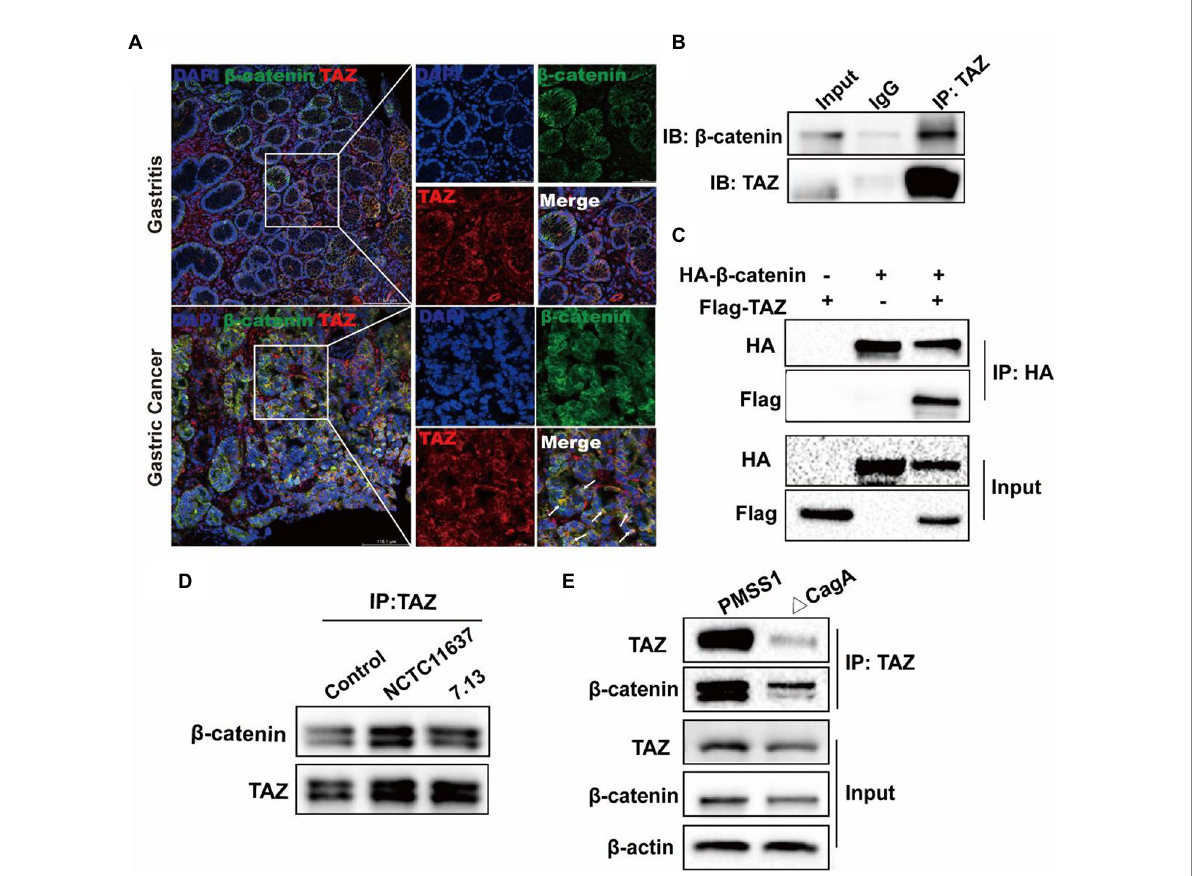
FIGURE 6 CagA+ H. pylori infection enhances the interaction of TAZ with β -catenin. (A) Immunofluorescence staining for TAZ and β -catenin colocalization in human gastritis and gastric cancer tissues (Magnification 200×, scale bars =116.1 μ m; and digital zoom, scale bars = 38.7 μ m). (B) Interaction between endogenous TAZ and β -catenin. Immunoprecipitation was performed with an anti-TAZ antibody followed by immunoblotting with the indicated antibodies. (C) Interaction between HA- β -catenin and Flag-TAZ. Immunoprecipitation was performed with an anti-HA antibody, followed by immunoblotting with the indicated antibodies. (D) AGS cells were cocultured with H. pylori NCTC11637 or 7.13 strain at an MOI of 100 for 6 h. Cell lysates were collected and then immunoprecipitated with anti-TAZ antibody. Western blotting was performed to assess TAZ and β -catenin expression. (E) After infection with the H. pylori wild-type strain or CagA- mutant for 6 h, cell lysates were collected. Infection with the H. pylori CagA- mutant resulted in a weak interaction of TAZ with β -catenin, compared with that treatment with wild-type H. pylori